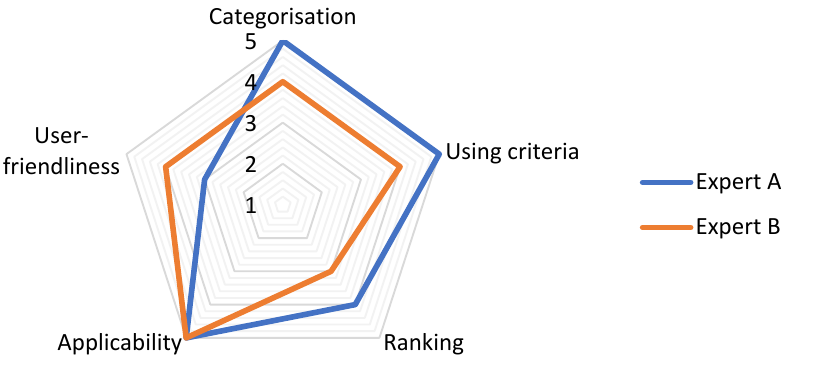
Figure 3. Validation results.